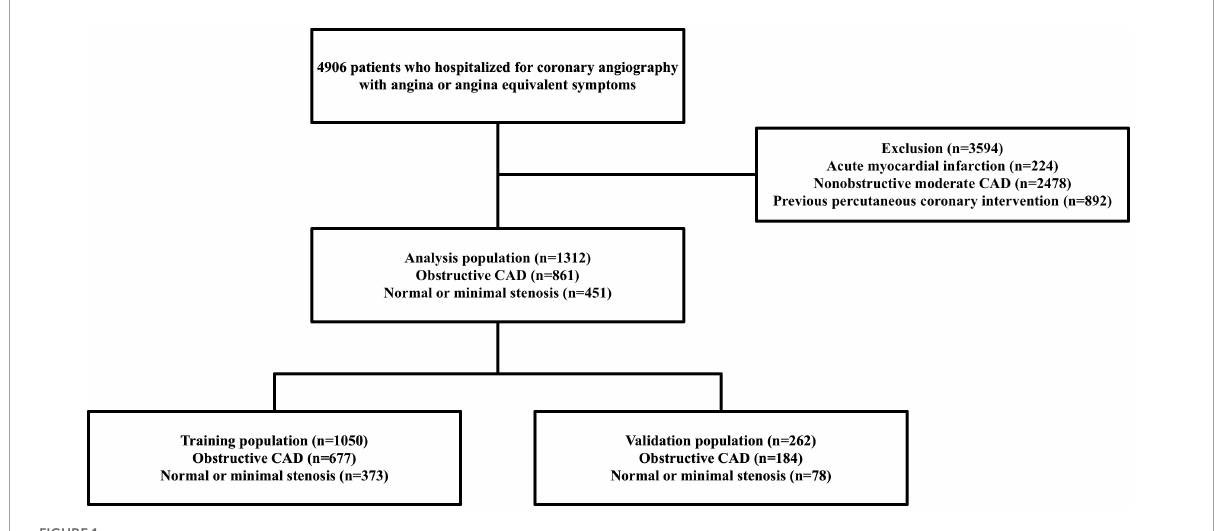
FIGURE1 Flowchart of the study population and process. CAD, coronary artery disease.